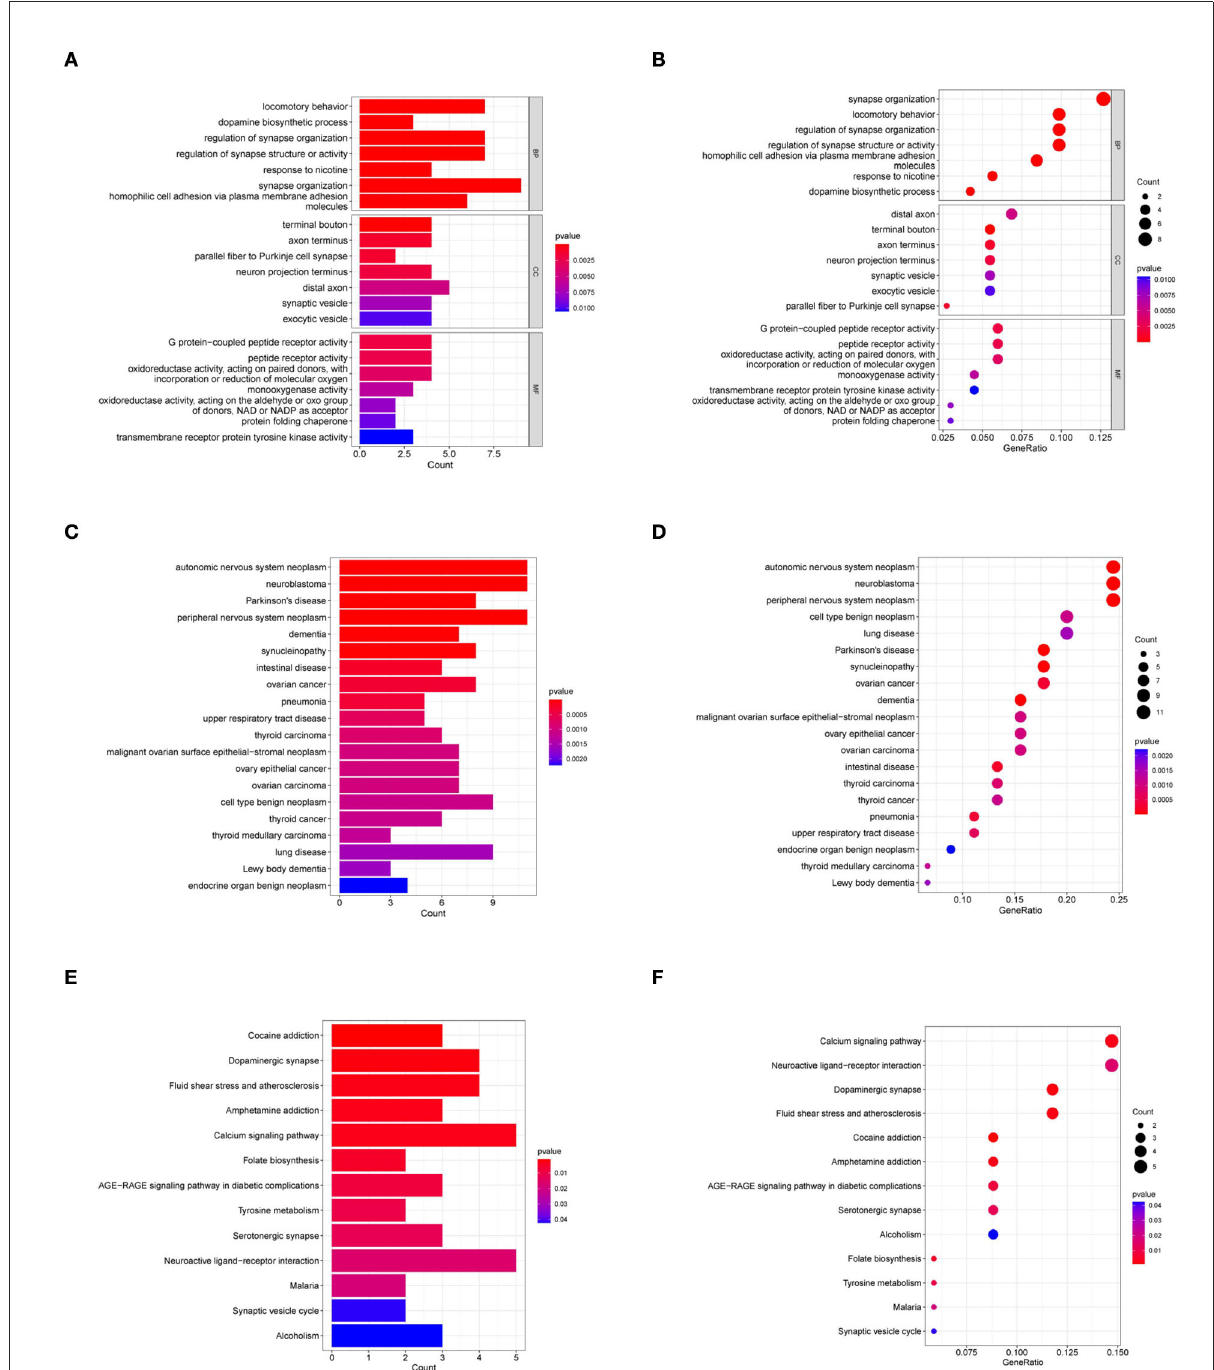
FIGURE3 GO, DO, and KEGG analyses of target genes. (A,B) GO analyses of target genes. (C,D) DO analysis of target genes. (E,F) KEGG analysis of target genes. BP, biological process; CC, cellular component; MF, molecular